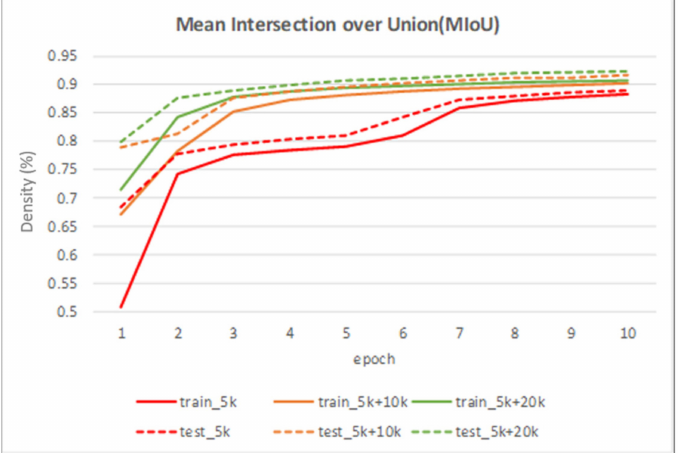
Figure 11. The mean intersection over union curve on training data and testing data.